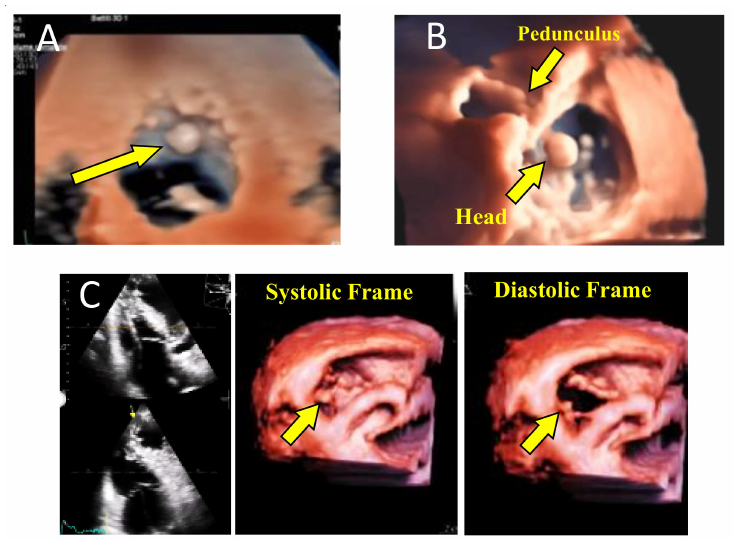
Figure 2. Three examples of cases in whom transthoracic 3D echocardiography (3DTTE) was par- ticularly useful: ( A ) left ventricle (LV) myxoma, ( B ) Tricuspid valve fibroelastoma and ( C ) precise localization of a pacemaker lead crossing the tricuspid valve.